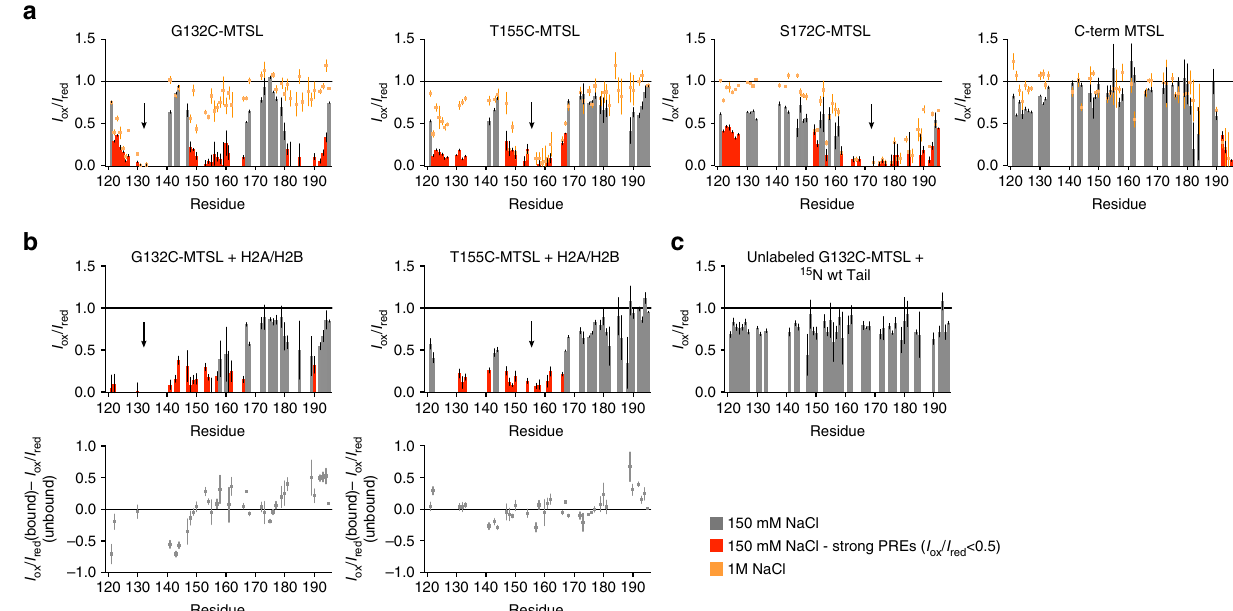
Fig. 3 Paramagnetic relaxation enhancement NMR (PRE-NMR) analysis of intramolecular contacts. a PRE intensity ratio graphs ( I ox / I red ) of the Npm tail domain with MTSL paramagnetic spin labels at four different positions (positions indicated by arrows) and at two different NaCl concentrations (gray/red bars = 150 mM NaCl, orange points = 1 M NaCl). Error bars are inversely proportional to the propagated signal-to-noise ratio of individual resonances. Signi fi cant PRE effects ( I ox / I red < 0.5) in the low-salt condition are highlighted in red. b Upper: I ox / I red graphs of the Npm tail domain bound to H2A/H2B. Two sets of intramolecular PRE effects derived from the complex (positions of spin labels indicated by arrows). Error bars are inversely proportional to the propagated signal-to-noise ratio of individual resonances. Same coloring scheme used as in a . Lower: Difference maps in I ox / I red values from the unbound and histone-bound states. Positive values indicate that residues are further from the spin label position after histone binding, negative values indicated that residues are closer to the spin label position after histone binding. c Intermolecular PRE effects measured using 1:1 molar ratio of non-isotope-labeled G132C-MTSL tail: 15 N-labeled tail at 200 µ M total protein concentration. Lack of strong PRE effects indicate very few or only transient intermolecular interactions. Error bars are inversely proportional to the propagated signal-to-noise ratio of individual